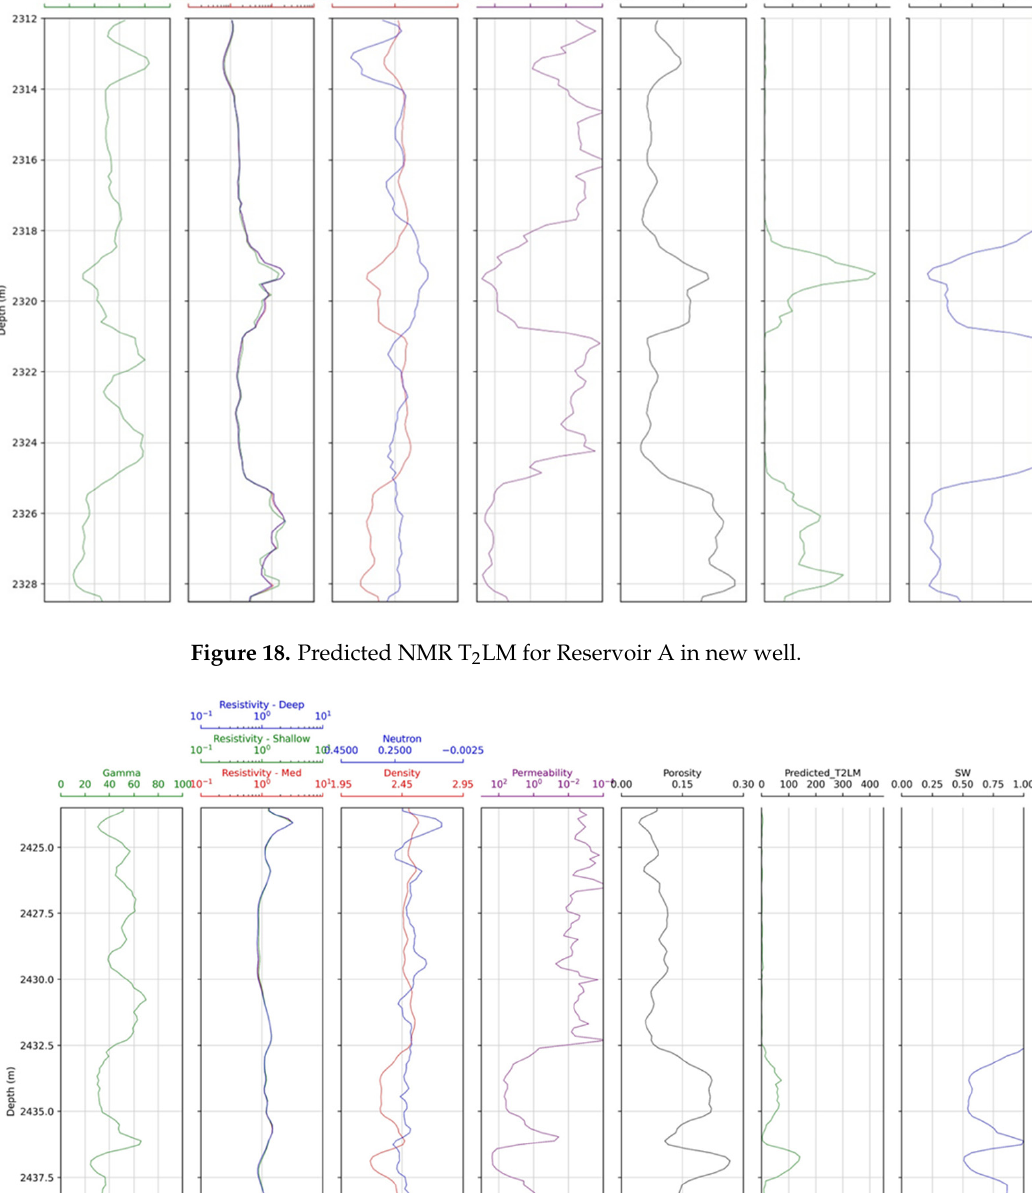
0.8 Figure 20. Plot showing the SW against T 2 LM trends in the new well. 00.2 0.4 0.6